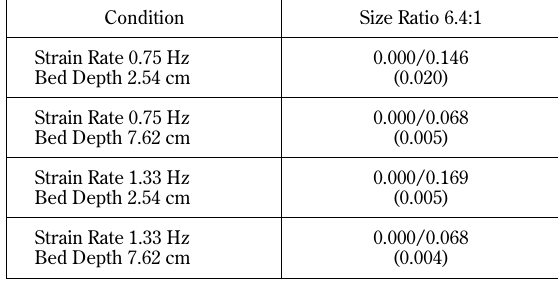
time data of the 5.1:1 size ratio. The average data of the 5.1:1 size ratio reduced the standard devia- tion by 77% when comparing to size ratio linear